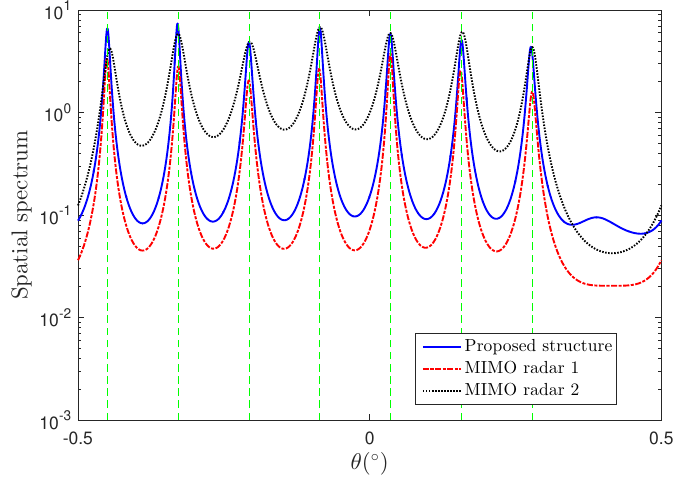
Figure 2. Spatial spectrum